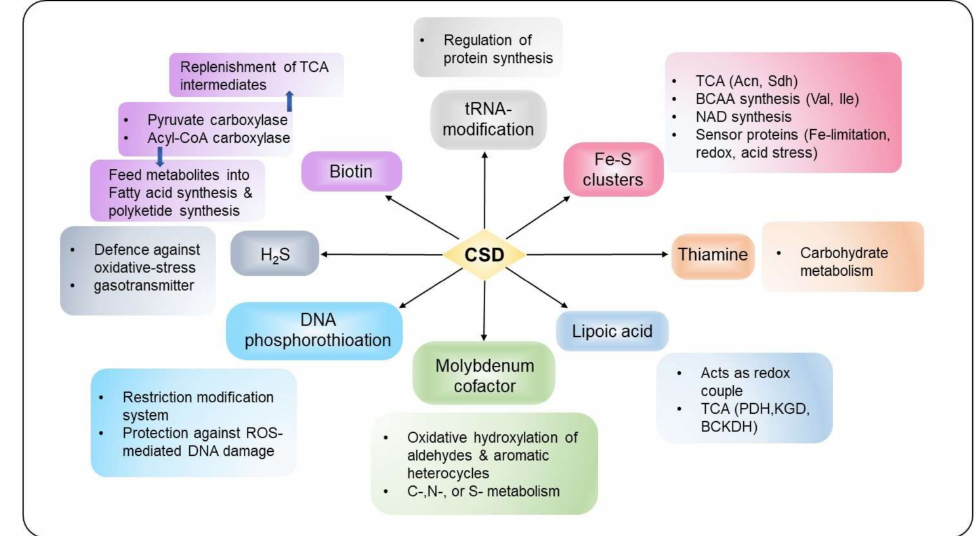
Figure 5. The interconnected network of S-transfer and incorporation into different thio-cofactors and tRNA. CSDs act as a pivotal point between diverse physiological functions, including cellular metabolism, stress response and protection, regulation of gene expression, and